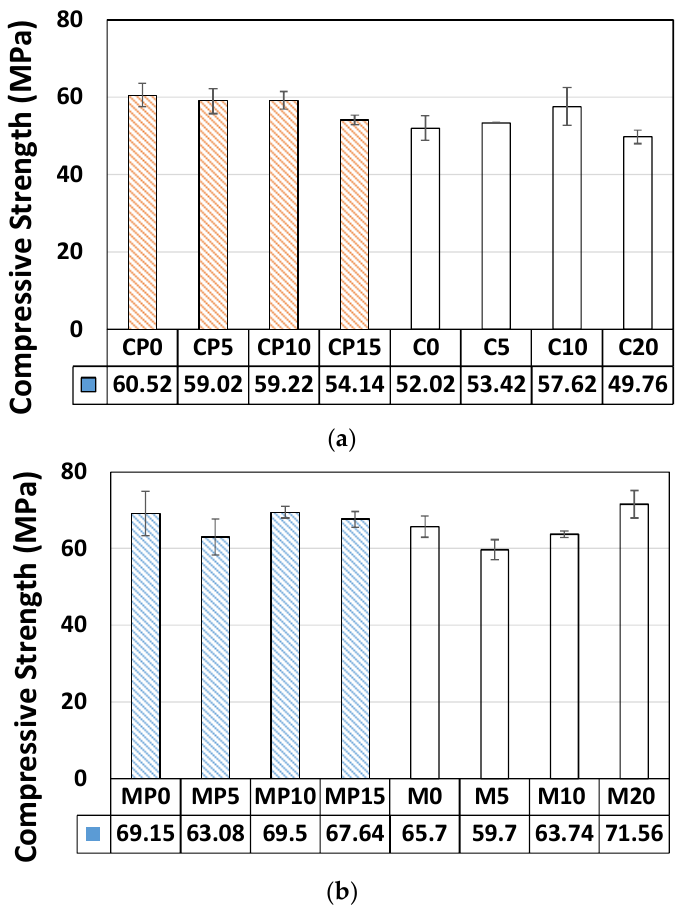
Figure 5. Compressive strengths of cementitious materials with different wt % values of P-25 and NP- 400. ( a ) Cement paste. ( b ) Mortar. (C: cement paste, MP: mortar with P-25, M: mortar with NP-400).